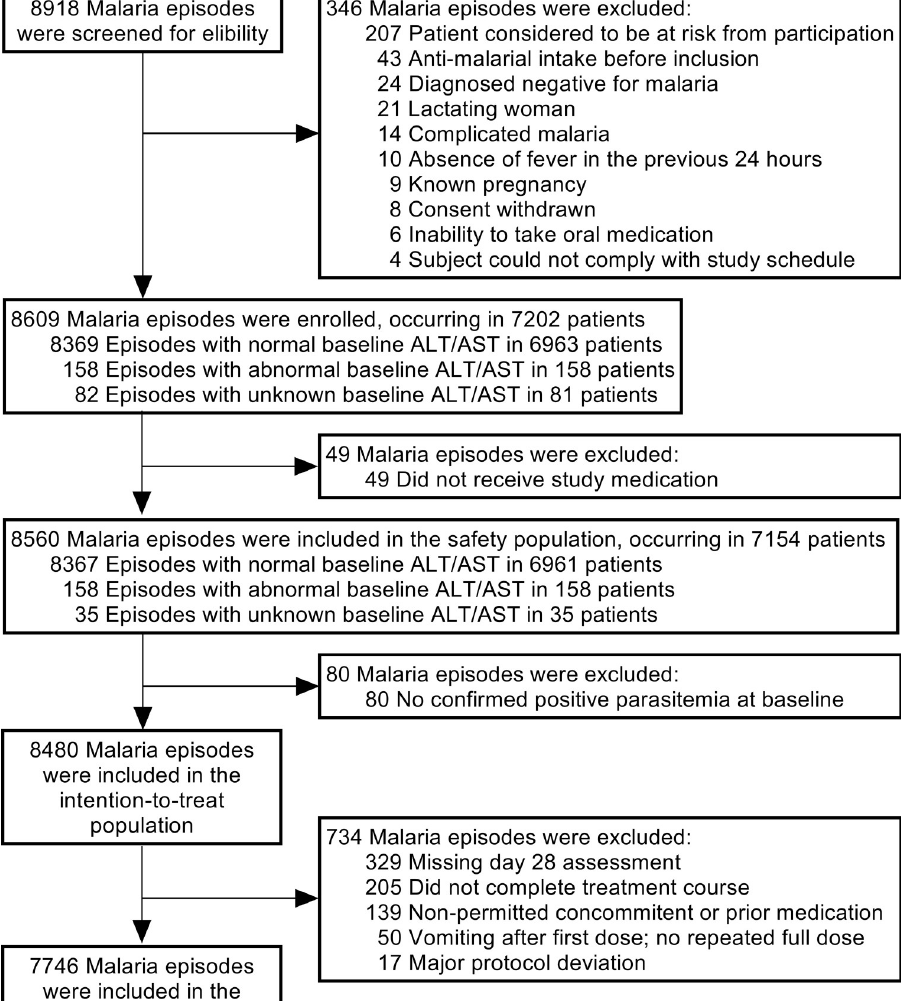
Fig 1. Screening and analysis populations. There may have been more than 1 reason for exclusion from enrollment into the study or exclusion from a study population. Normal LFTs were ALT or AST � 2 × ULN and abnormal values were ALT or AST > 2 × ULN at baseline. “Patient considered to be at risk from participation” included patients that investigators considered inappropriate for trial inclusion, mainly because of low hemoglobin or an inability to draw blood for assessments. Note that no patient with clinically evident preexisting liver injury was excluded from the screening population. ALT, alanine aminotransferase; AST, aspartate aminotransferase; LFT, liver function test; ULN, upper limit of